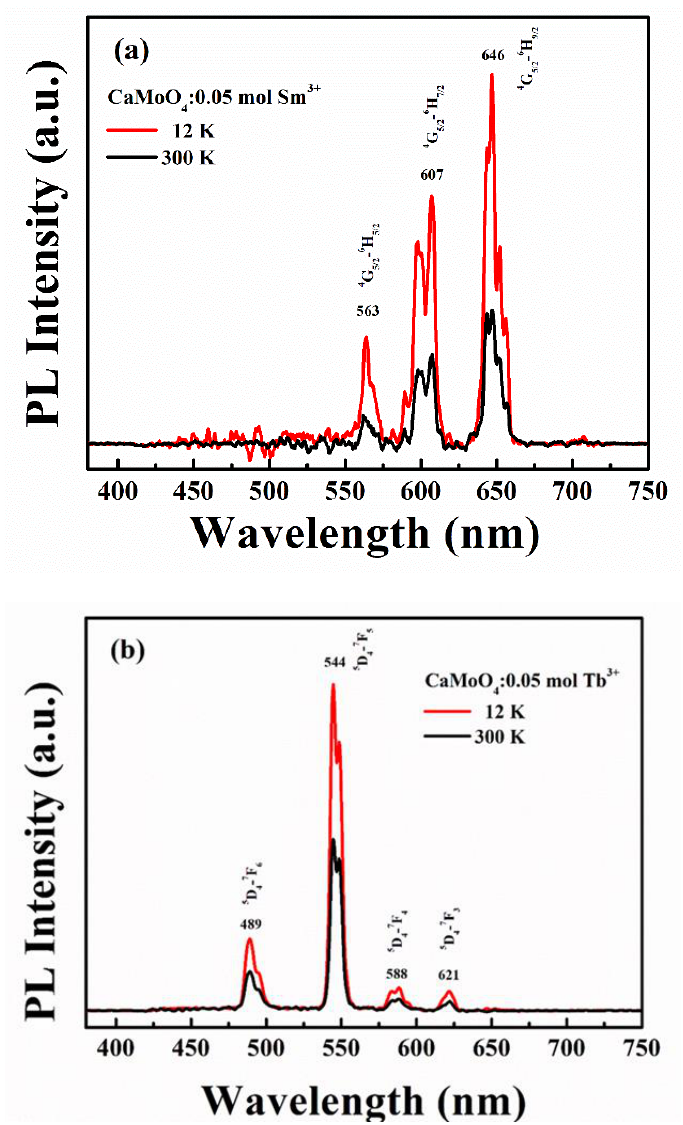
. 3+ ions and ( b ) 0.05 mol Tb 3+